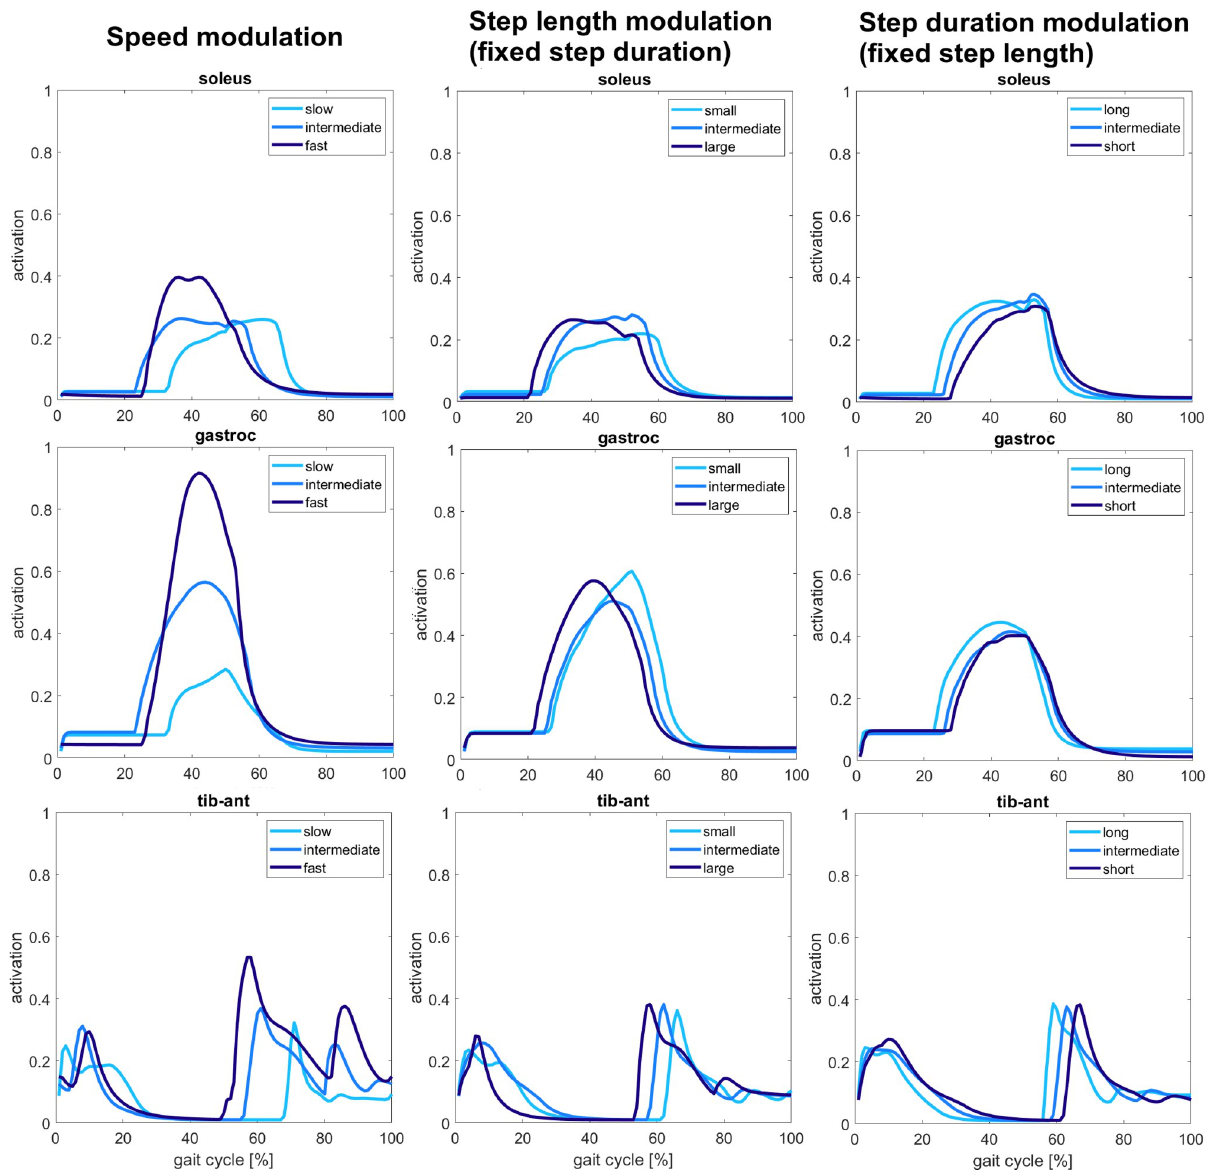
Fig 10. Ankle muscles activity. Soleus and gastrocnemius activity increase with the increase of speed, but no significant changes are seen for the modulation of step length and step duration. Similarly, tibialis anterior activity increases with speed, whereas for step length and step duration modulation, it can be observed anticipation and delay of activation during the gait cycle for large step lengths and short durations,